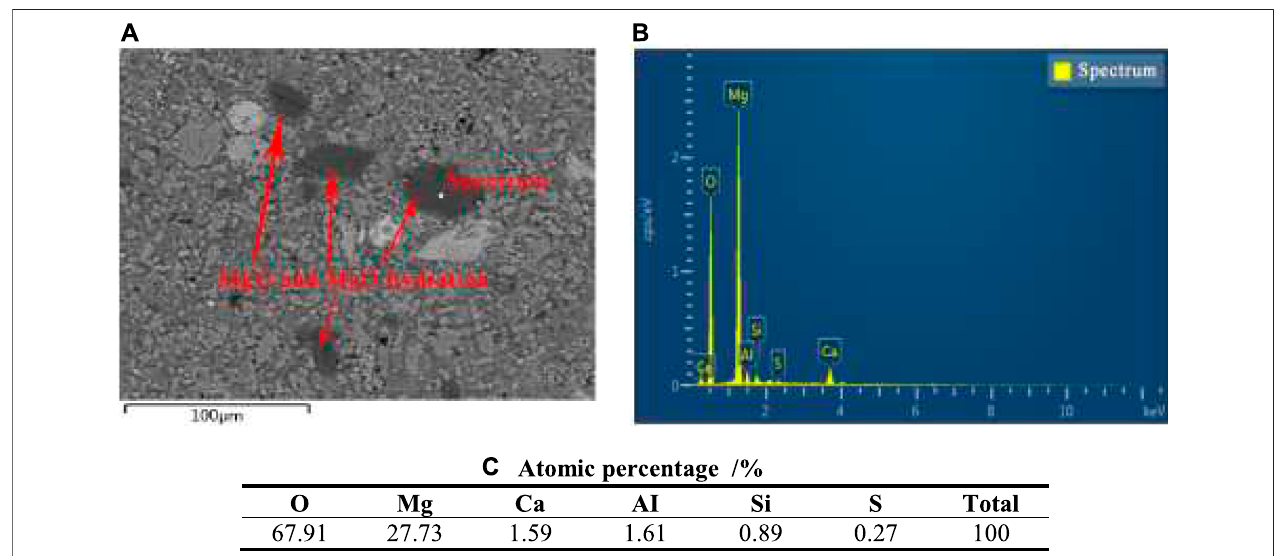
FIGURE 8 | Energy spectrum analysis diagram of a large-size concrete specimen mixed with 10% MgO. (A) Backscattered electron image. (B) Micro-area composition of energy spectrum. (C) Atomic percentage.